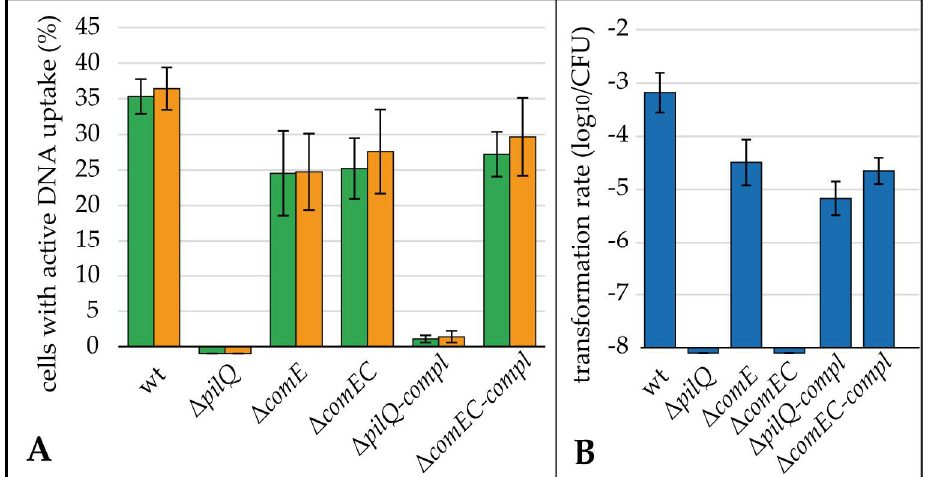
Figure 4. DNA uptake and transformation rate in 81–176 (wt), the ∆ pilQ , ∆ comE , ∆ comEC mutants and the complemented strains ∆ pilQ-compl and ∆ comEC-compl . ( A ) Cells were incubated with fluorescein (green bars) or Cy3 labelled (orange bars) DNA of strain 81–176 and the fraction of cells with at least one active uptake location was counted; ( B ) Transformation rate was determined in parallel using a streptomycin marker. Mean and standard deviations are shown from ≥ 4 independent experiments. ∆ comE displayed a marginally reduced fraction of bacteria with active DNA